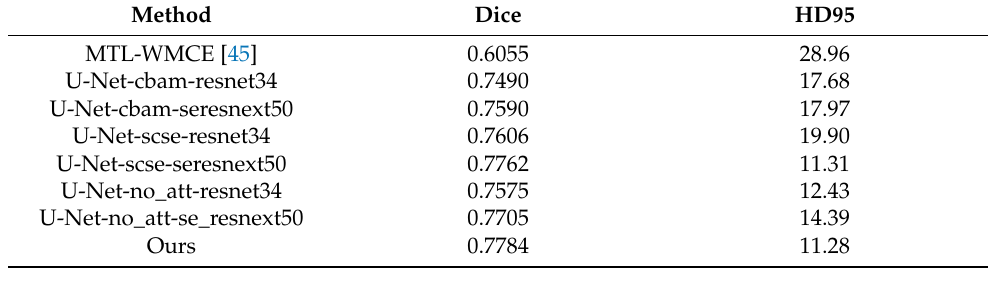
Table 2. Dice score and HD95 score of esophagus segmentation comparison between our proposed method with others in StructSeg 2019 training set.